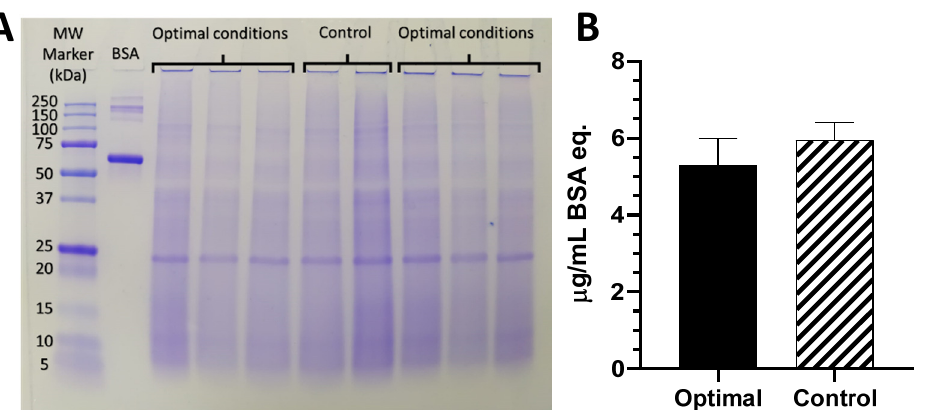
Figure 9 . ( A ) Protein profile and molecular weight distribution of the P. tricornutum extracts, comparing the ultrasound-assisted extraction (UAE) optimal conditions vs. the control conditions (shaking). The optimal conditions with UAE had six replicates, while the control conditions for extraction (shaking) had two replicates. ( B ) Relative quantification of the band at 23 kDa (fucoxanthin) based on a BSA sample at 60 µg/mL.